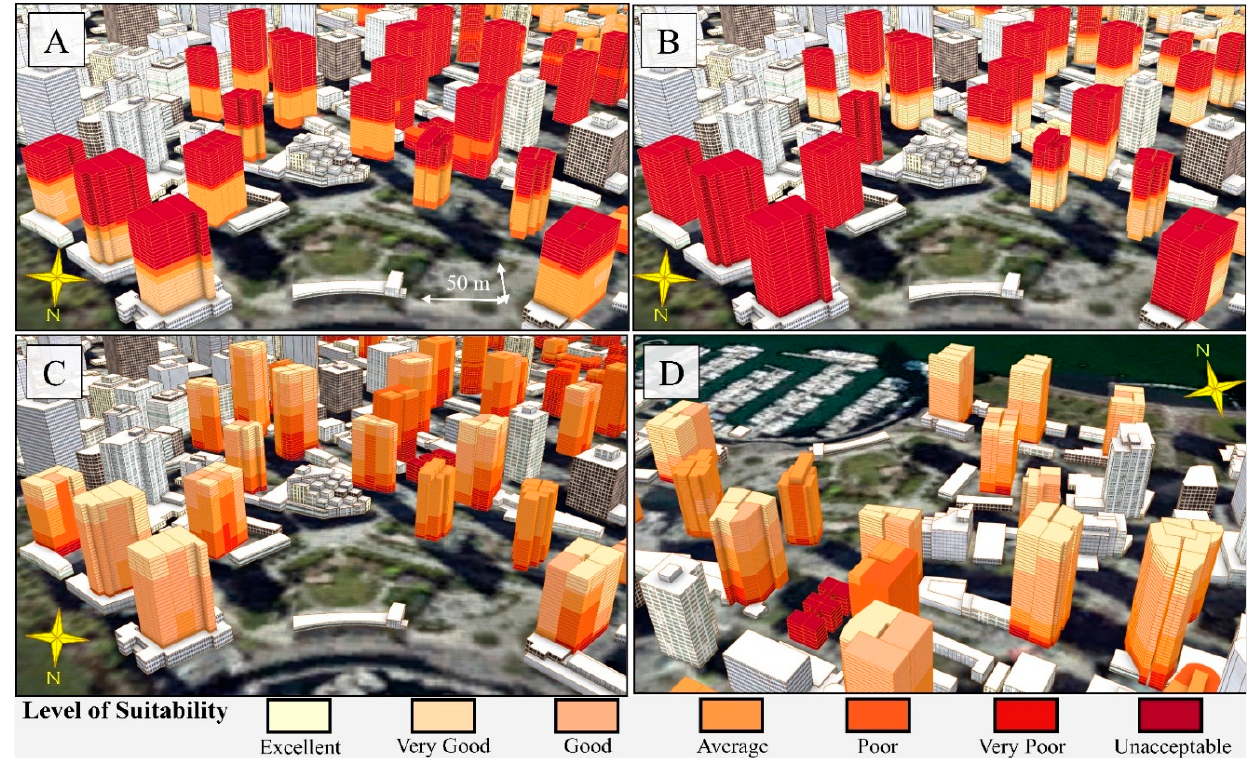
Figure 6. Suitability values obtained from the 3D LSP–MCE analysis for a subset of buildings under Scenarios ( A ) 1, ( B ) 2, and ( C ) 3 facing south and ( D ) Scenario 3 facing north.